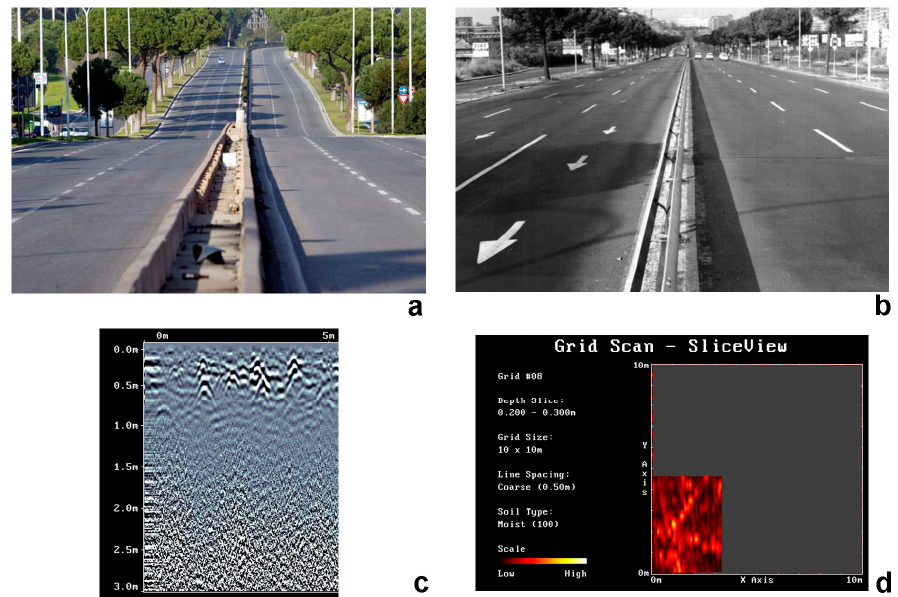
Figure 6. The upper images show Via Cristoforo Colombo in recent times ( a ) and during the 1950s ( b ). The lower images clearly show the very shallow root architecture of the pine trees beneath the asphalt road surface (hyperbolic events in ( c ) and yellow elongated anomalies in ( d ). Note, however, that the asphalt surface is not yet damaged by root growth.